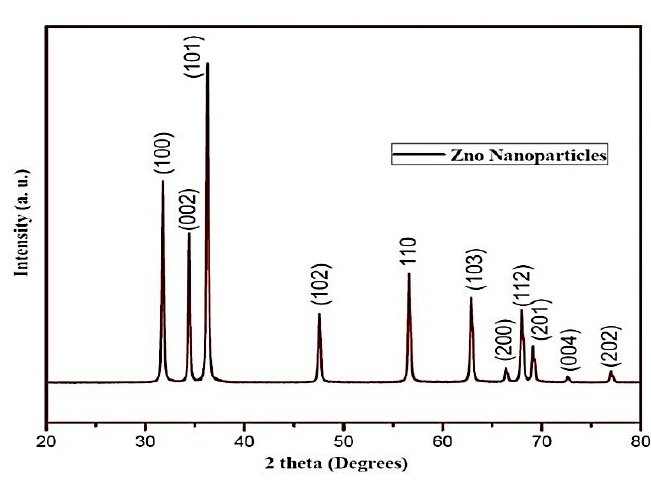
Figure 3. XRD pattern of zinc oxide NPs.